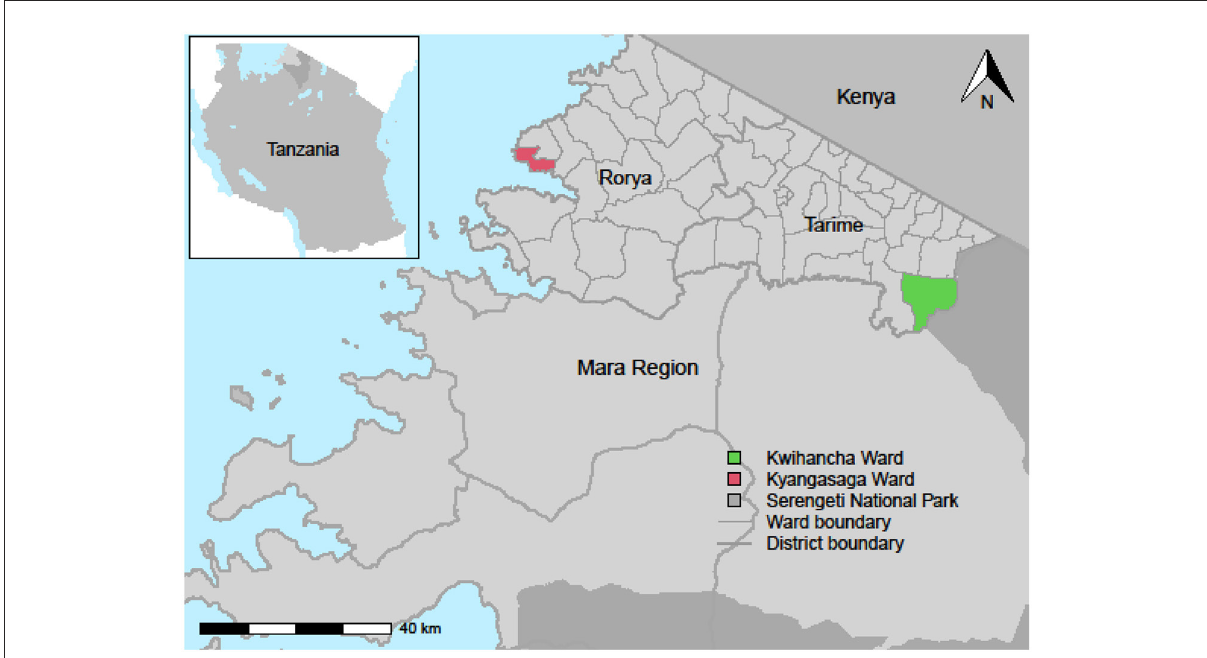
FIGURE1 Map of Mara region in Tanzania showing locations of the two wards where the community and public engagement activities were conducted.